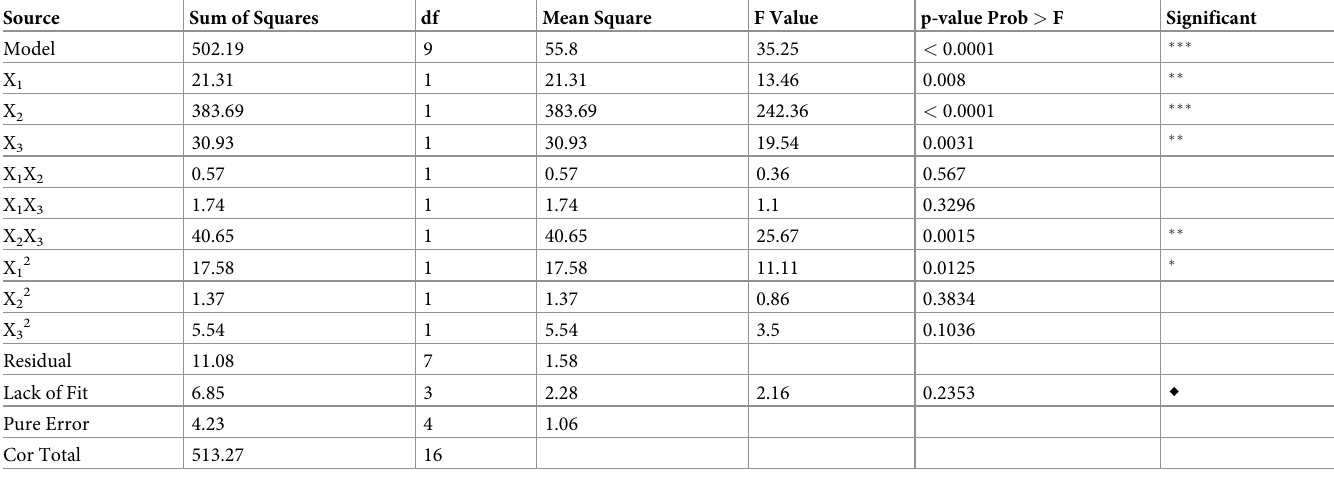
Table 2. ANOVA for response surface quadratic model analysis of